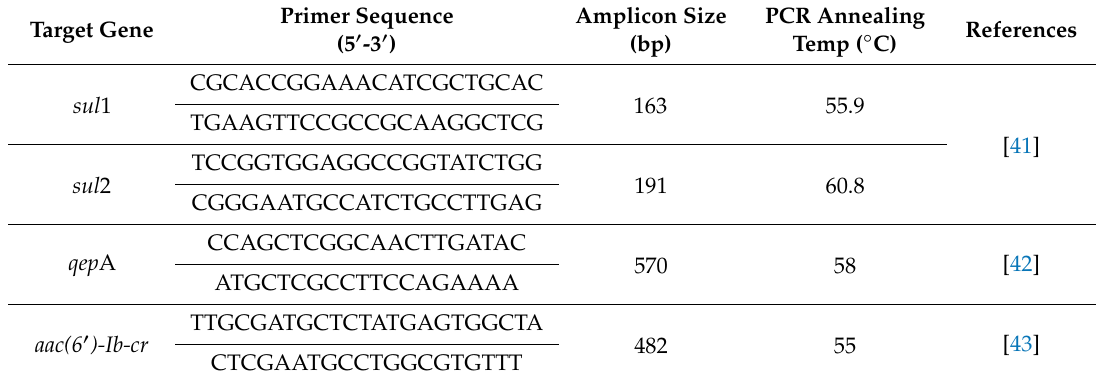
Table 2. Polymerase chain reaction (PCR) primers and